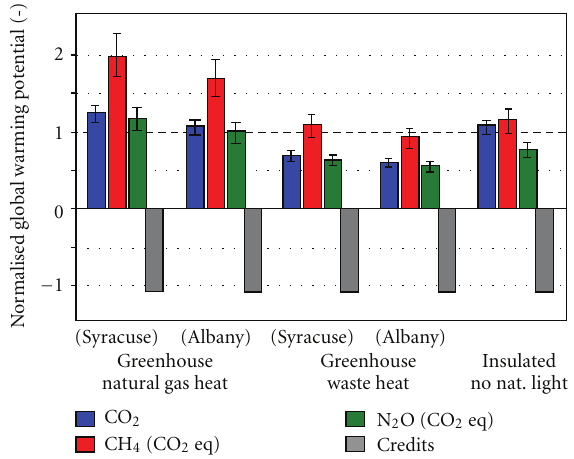
Figure 8: Global warming potential of microalgae biodiesel—mass emissions normalized by dividing by the corresponding emissions for soy biodiesel for